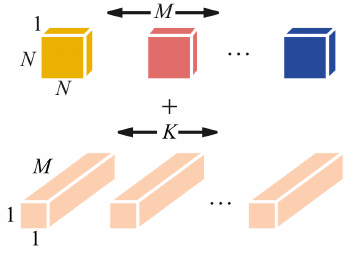
Figure 2. Depthwise convolution and pointwise